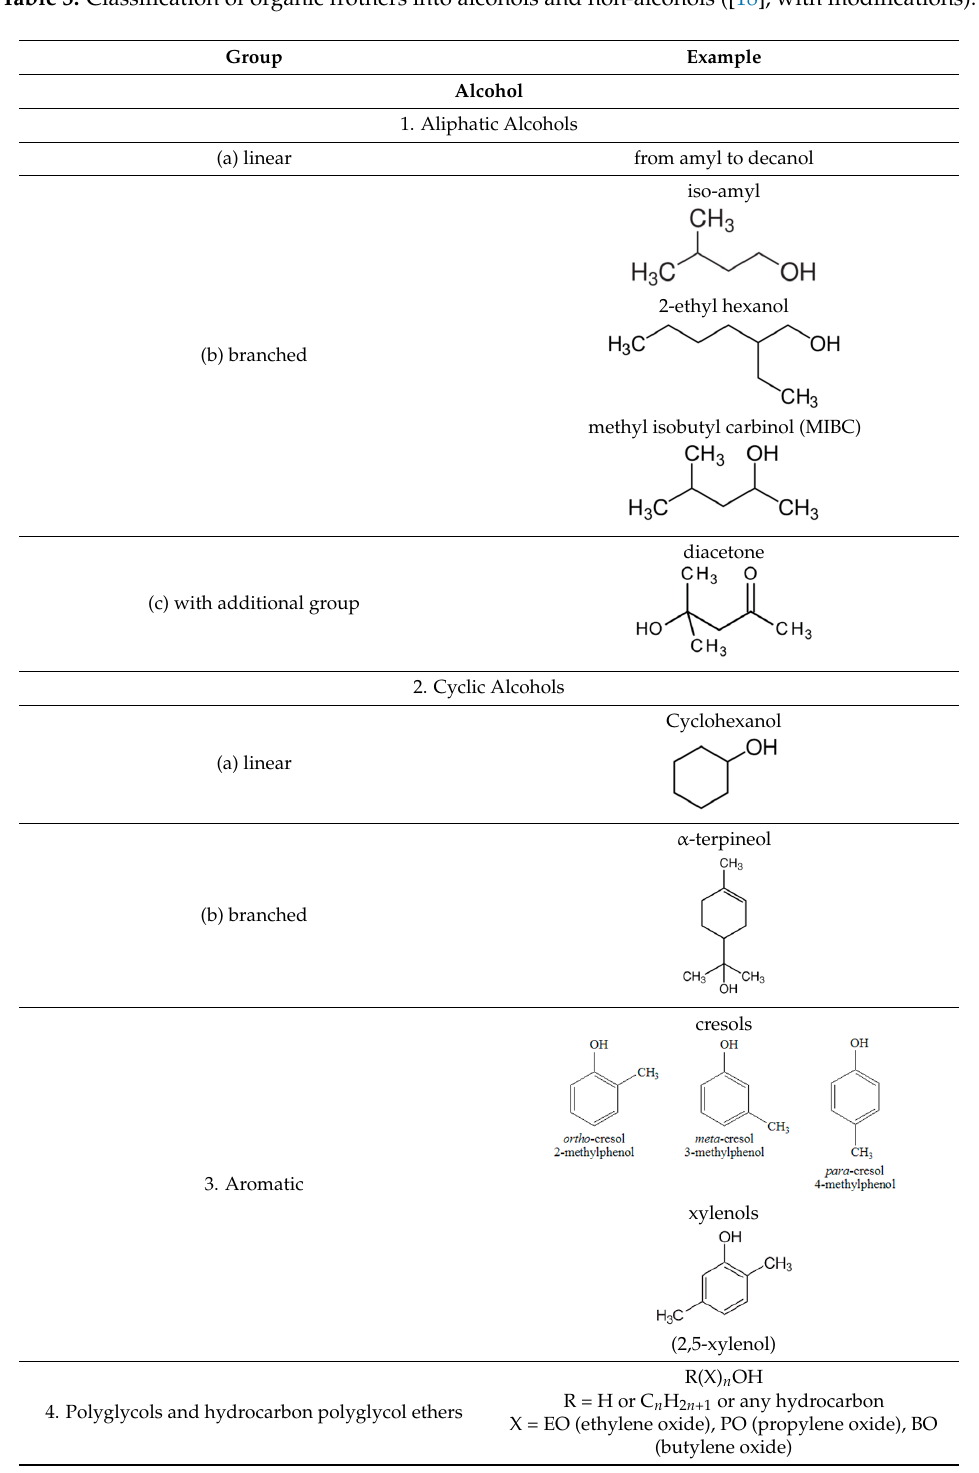
Table 2. Classification of frothers into organic and inorganic.